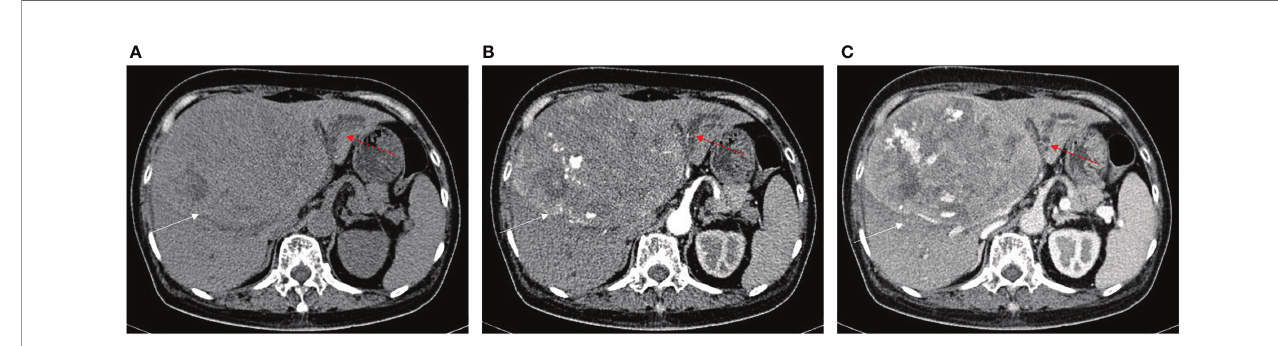
FIGURE 6 | HCC without BDTT. (A) The HCC lesion (white arrow) and bile duct dilation in S2, S3, and S4 (red arrow) show hypoattenuation in plain CT image. (B) The HCC lesion has early enhancement (white arrow) in arterial phase, and bile duct dilation in S2, S3, and S4 (red arrow). (C) The HCC lesion (white arrow) shows hypoattenuation at portal venous phase, accompanied by closed bile duct dilation (red arrow) in S2, S3, and S4.